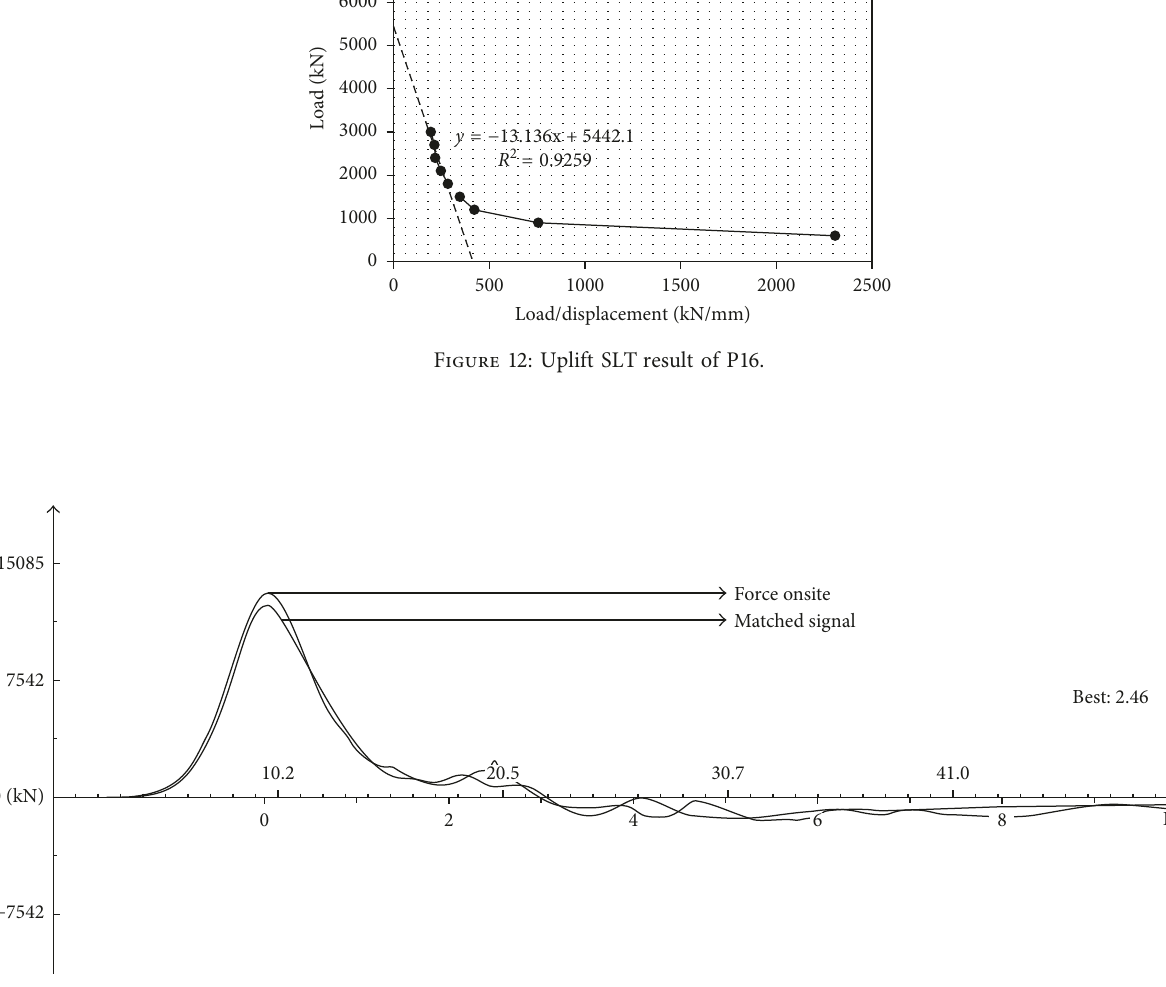
Figure 13: CAPWAP results of